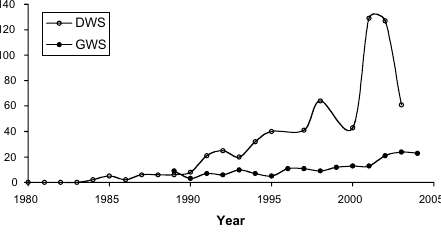
Fig. 5. Maximum numbers of grey seal pups counted in the Dutch (DWS) and German (GWS) Wadden Sea through the period